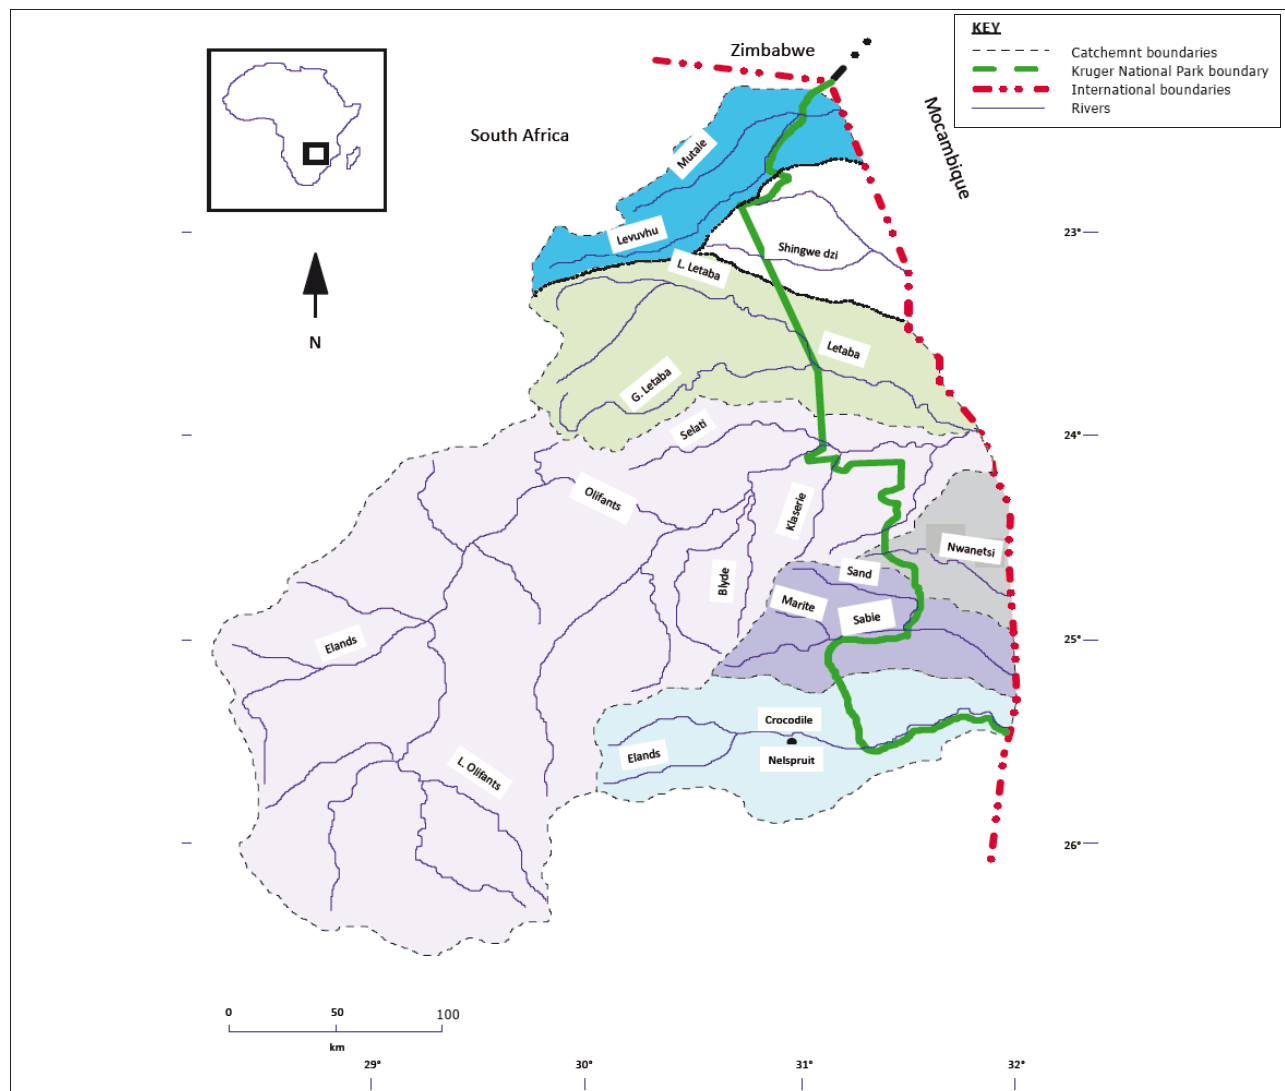
FIGURE 1: Map indicating the major river systems and associated catchments of the eastern escarpment, lowveld and Kruger National Park, South Africa. Anthropogenic changes have meant that of the six historically perennial systems, only the Sabie River has remained